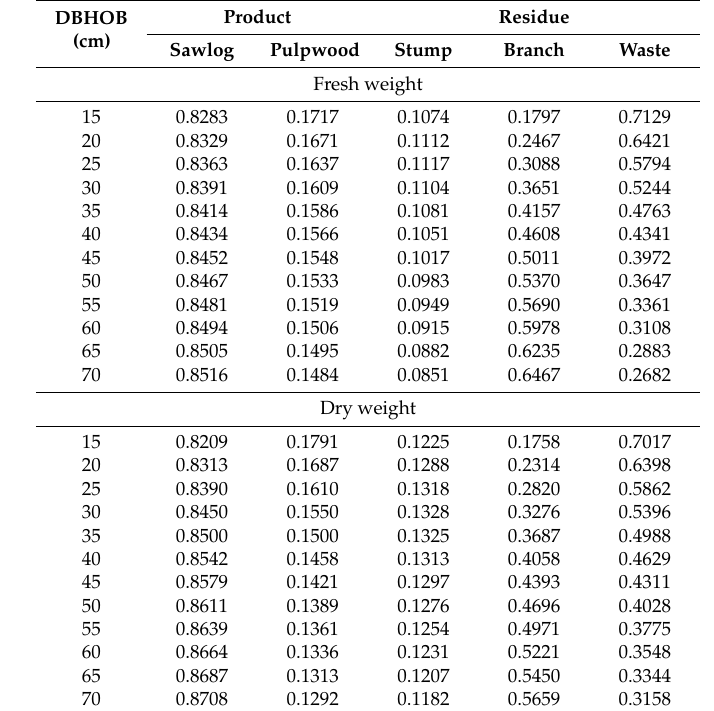
Table 9. Fractions of the sub-components in the product and residue fresh and dry weight as predicted by the two systems of allocative Equations (12) and (13) using the parameter estimates in Table 8. Product Residue DBHOB (cm) Sawlog Pulpwood Stump Branch